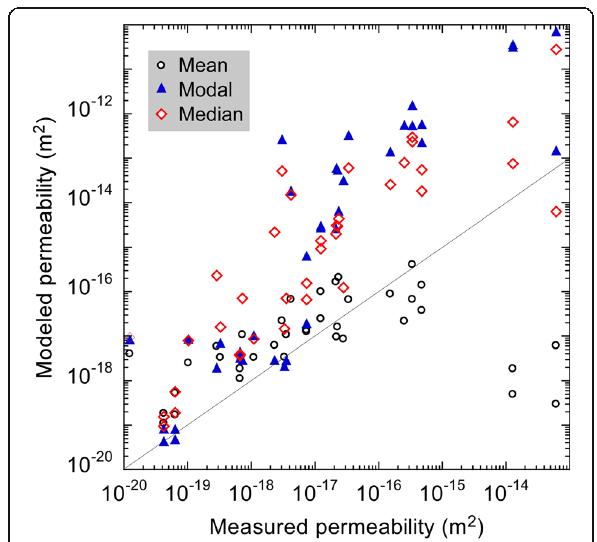
Fig. 9 Comparison of measured permeability at an effective pressure of 3 MPa with predicted permeability. The permeability was calculated from the modal pore size distribution using Eqs. (5) and